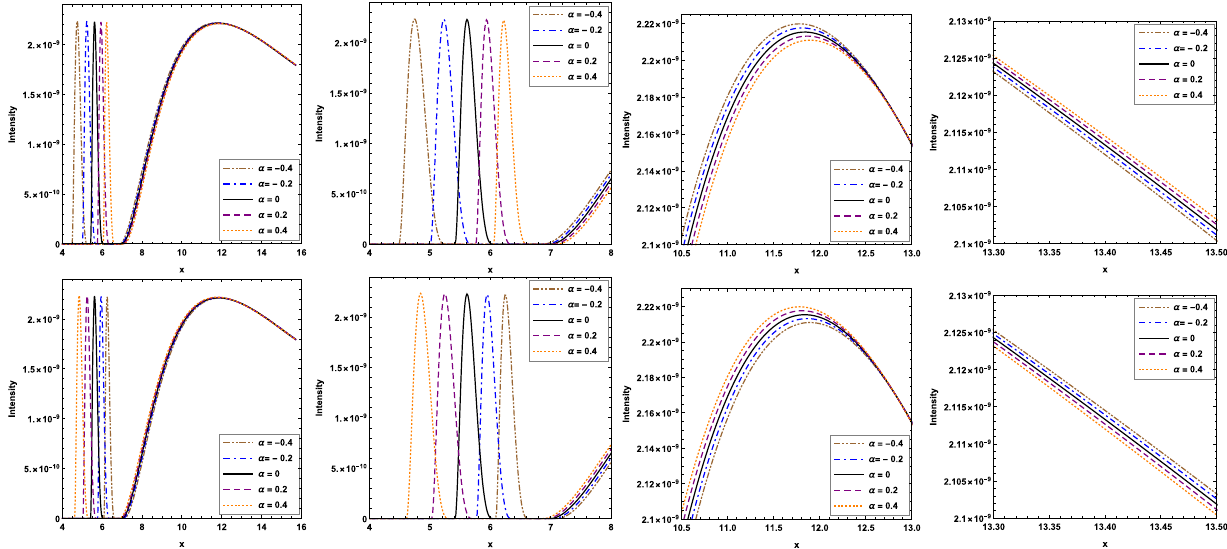
Fig. 4 The intensity distribution curve of images along the line y = 0 for the observer with inclination angle θ o = 0 ◦ . The upper row is for the PPL and the bottle row is for the PPM, respectively. Here, we set M = 1